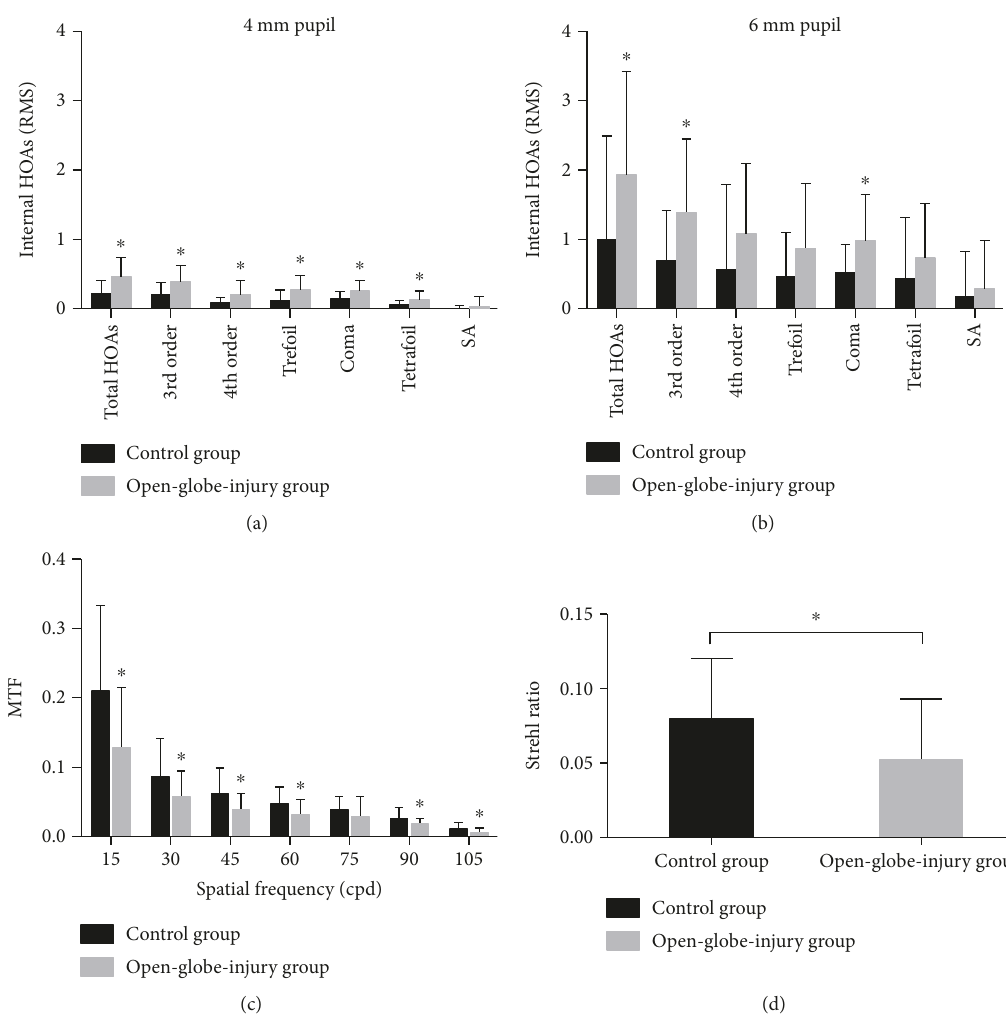
Figure 2: Internal higher-order aberrations (HOAs) and optical quality in the control and open-globe-injury groups. (a) and (b) show the internal HOAs in the two groups at pupil diameters of 4 mm (a) and 6mm (b). At a premydriatic pupil size of 4mm, most internal HOA values were signi fi cantly higher in the open-globe-injury group than in the controls. After mydriasis, only total HOAs, third-order HOAs, and coma di ff ered signi fi cantly between the two groups. In (c), MTF at spatial frequencies of 15, 30, 45, 60, 90, and 105 cycles/degree were signi fi cantly lower in the open-globe-injury group than in the controls. (d) indicates signi fi cantly lower Strehl ratio in the open-globe- injury group than in the controls. ∗ P < 0 05 .